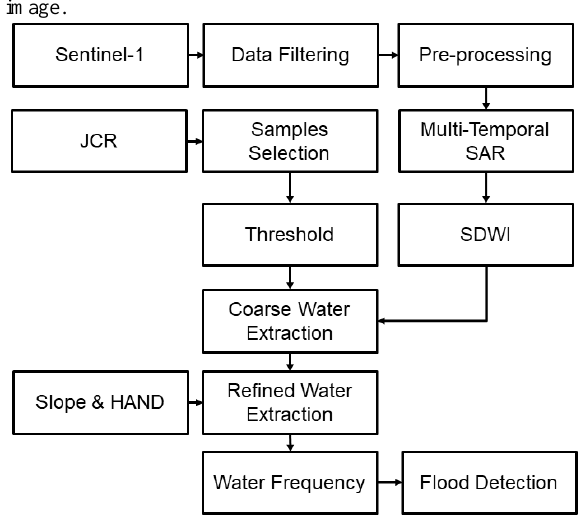
Figure 2 Flowchart of this